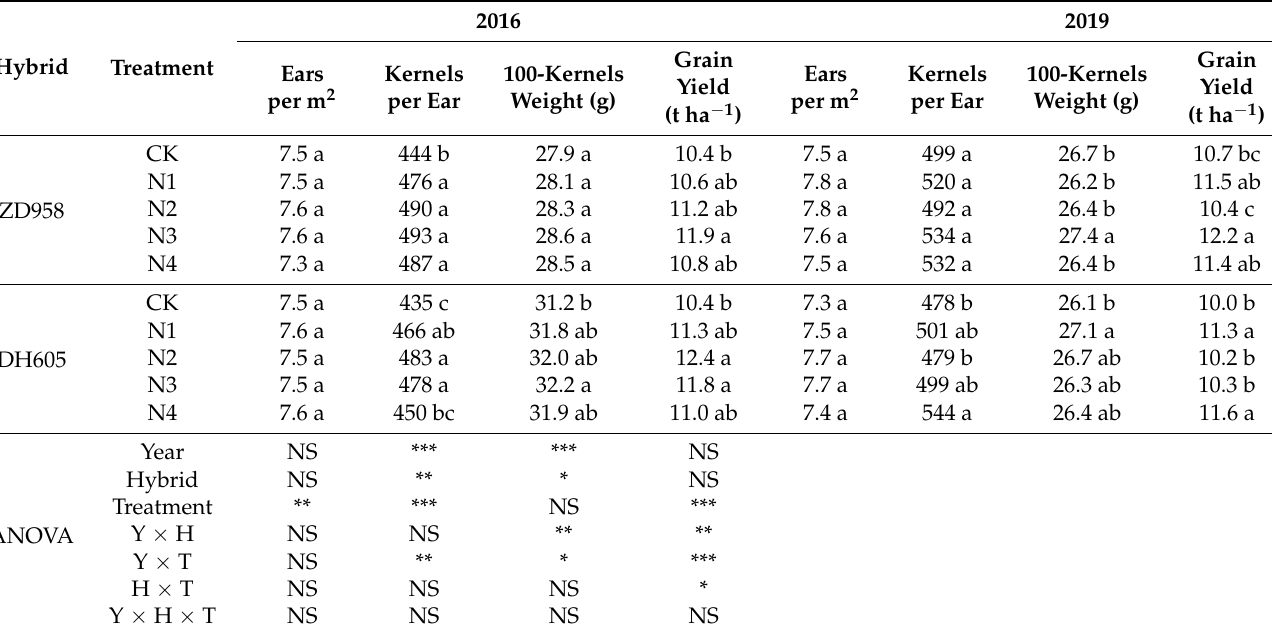
Table 2. Effects of N treatments on maize yield and yield